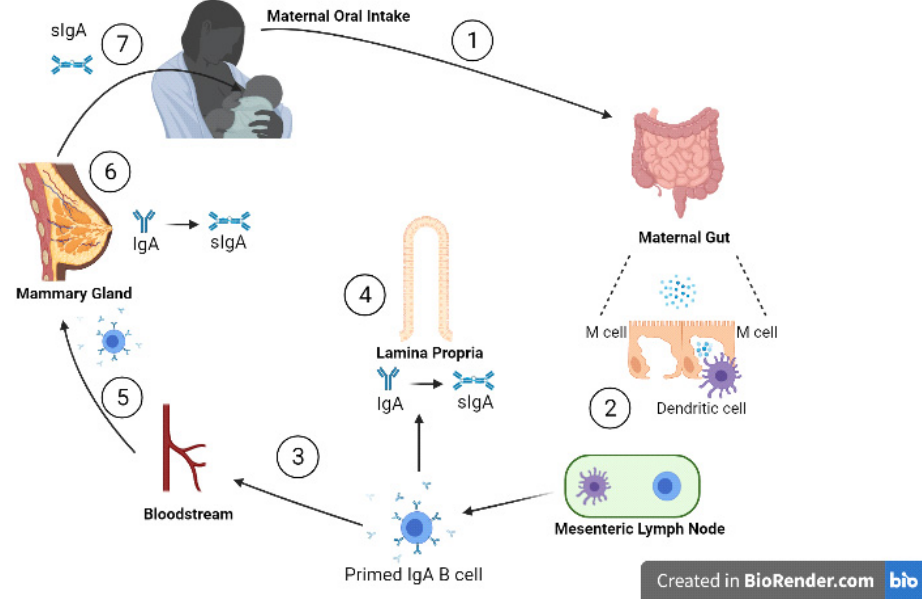
Figure 2. Entero-mammary circulation allows the transportation of maternal immunoglobulins into the infant, via human milk. ( 1 ) Viral particles are ingested orally and pass to the gut; ( 2 ) inside the gut wall dendritic cells sample viral antigens, presenting them to local lymphatic cells; ( 3 ) primed IgA B cells travel to ( 4 ) the lamina propria and ( 5 ) the mammary stroma lining the ductal system via the bloodstream; ( 6 ) on the basolateral side of the mammary ductal system, IgAs are produced by plasma cells in the mammary gland. The IgAs are transported across alveolar epithelial cells by polymeric Ig receptors, where they bind to the secretory components to form sIgAs; ( 7 ) sIgA passes into the infant gut lumen to provide protection from viruses through a range of mechanisms. (adapted from Newburg D and Walker W, 2007 [12]). Created with